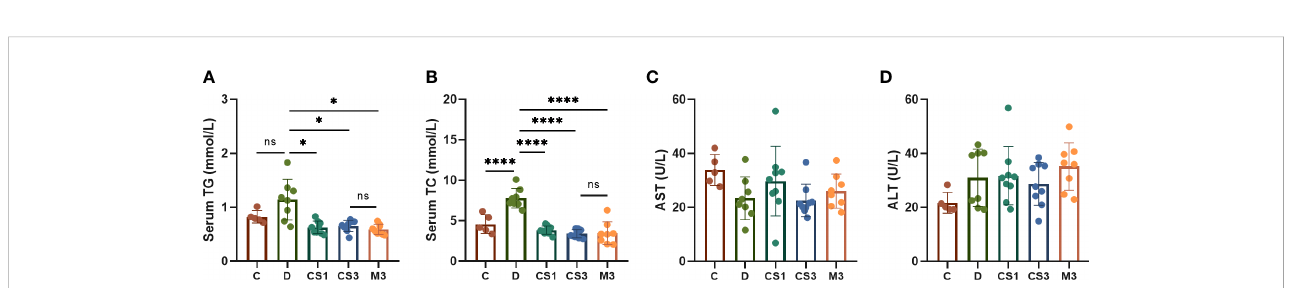
FIGURE 3 Effects of CS271011 and MGL-3196 on serum parameters in the DIO model. (A) Serum TG level; (B) Serum total TC level; (C) Serum AST level; (D) Serum ALT level. All data are expressed as the mean ± SD. *p < 0.05 and ****p < 0.0001 represent data vs. DIO controls; ns, not signi fi cant. C, chow diet control group (n=5); D, DIO control group (n=8); CS1, CS271011 1 mg/kg group (n=9); CS3, CS271011 3 mg/kg group (n=9); M3, MGL-3196 3 mg/kg group (n=8); TG, triglycerides; TC, cholesterol; AST, aspartate transaminase; ALT, alanine transaminase.